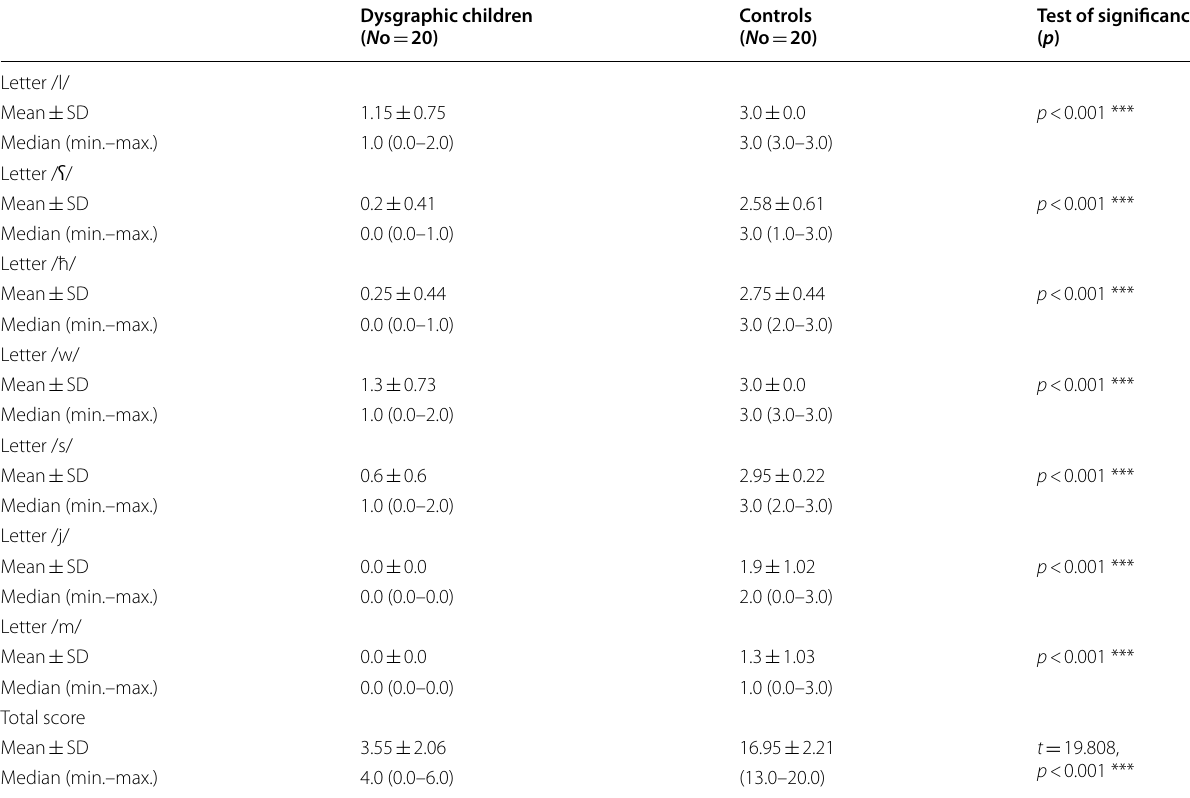
Table 2 Distribution of the studied sample according to each